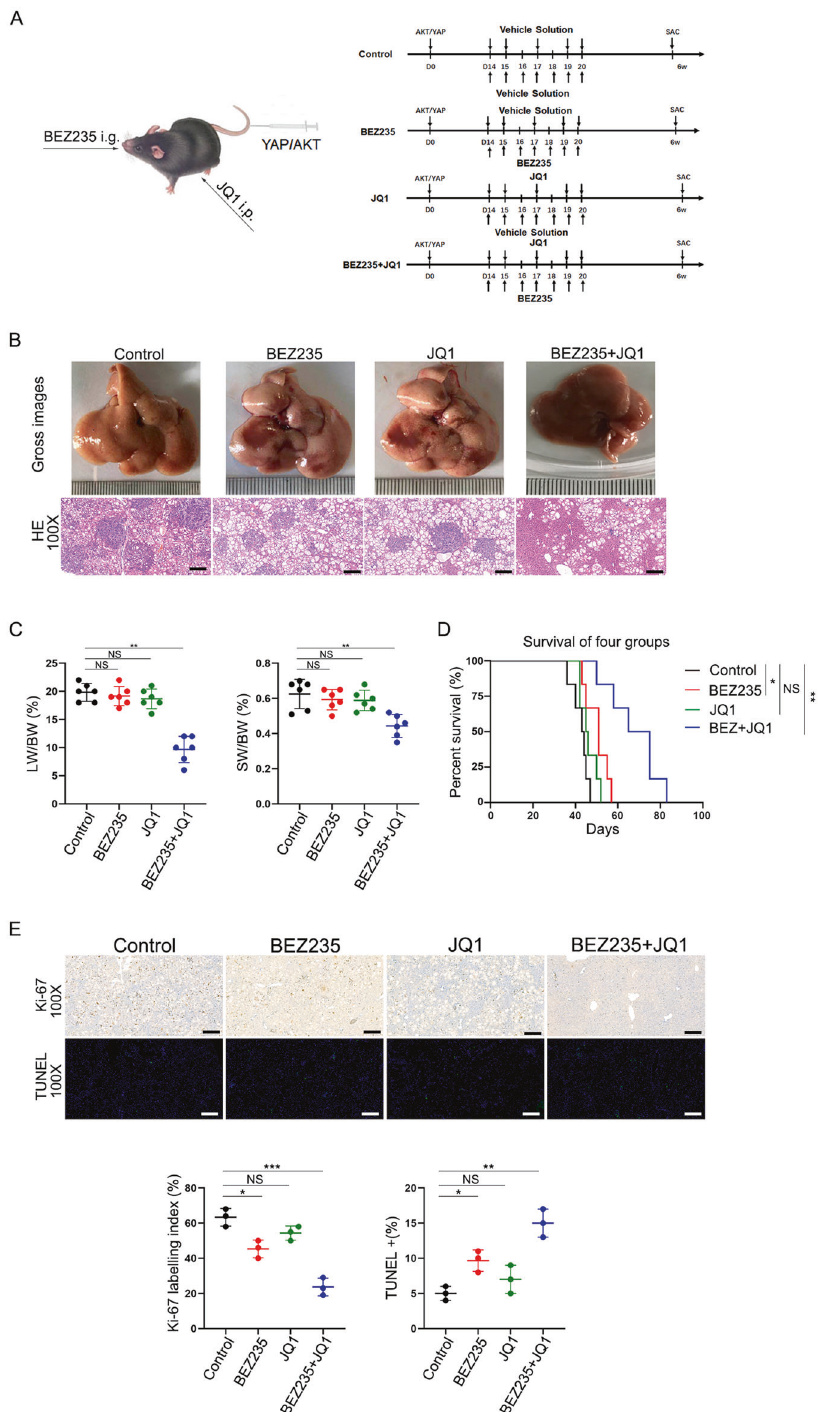
Fig. 6 The combination of BET protein inhibition and PI3K/mTOR dual inhibition ef fi ciently suppressed ICC progression in vivo. A Schematic of the experimental procedure for BEZ235, JQ1, or the combination treatment. The plasmids were transfected into all mice at day 0. JQ1 (50 mg/kg) (or vehicle solution) was i.p. injected at 14 – 20 days, and BEZ235 (30 mg/kg) (vehicle solution) was i.g. treated at 14 – 20 days, twice a day. All mice were sacri fi ced 6 weeks after oncogene transfection for phenotypic analysis. B Gross images, H&E staining of livers from four AKT/YapS127A mice groups. Magni fi cation, ×100; scale bar, 100 μ m. C Tumor burdens were calculated by LW/BW ratio, SW/BW ratios. The data are expressed as the means ± S.E.M ( n = 6 per group, NS, P ≥ 0.05, ** p < 0.01) for any other groups versus the control group. D Mouse Kaplan – Meier survival curve of the 4 treatment groups. Quanti fi ed data are presented as mean ± SE (NS, P ≥ 0.05, * P < 0.05, ** p < 0.01). E immunohistochemical or immuno fl uorescence staining images of Ki-67 and TUNEL in liver sections to assess the tumor proliferation. Magni fi cation, ×100; scale bar, 100 μ m. The data are shown as the mean ± S.E.M (NS, P ≥ 0.05, * p < 0.05, ** p < 0.01, *** p < 0.001).